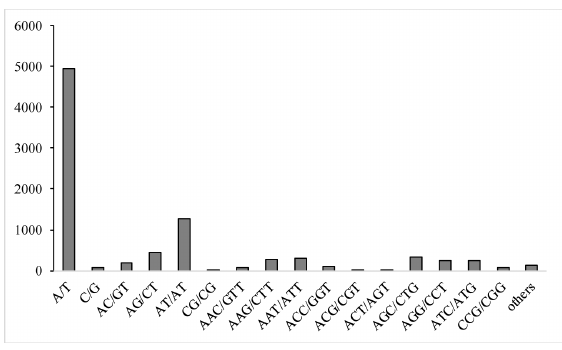
Figure 3. The number s and motifs of simple sequence repeats (SSR) of P. bungeana